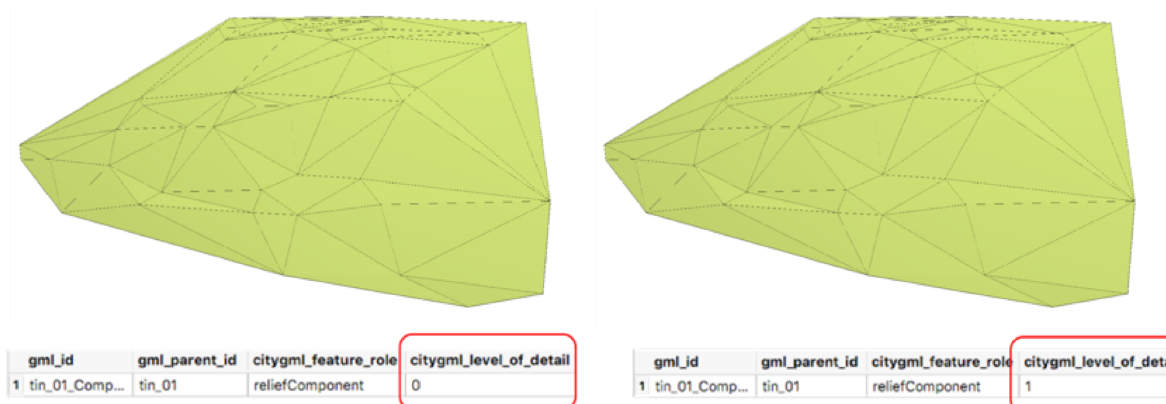
Figure 1. Two CityGML terrains ( TINRelief ) at different LODs, both perfectly valid according to the CityGML description. No distinction between the different LODs of a terrain at geometric and semantic level can be